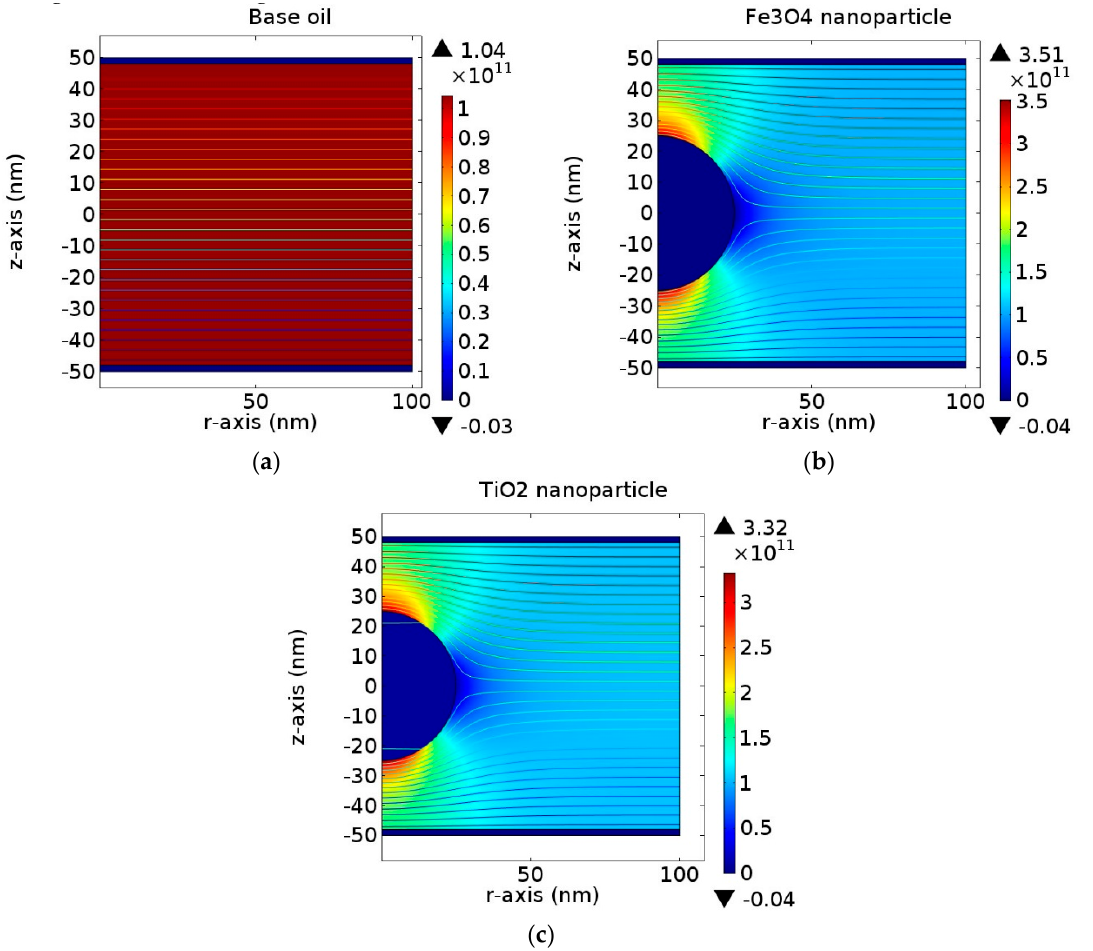
Figure 9. Electric field (V/m) distribution and electric equipotential lines for ( a ) base oil, ( b ) with Fe 3 O 4 and ( c ) TiO 2 nanoparticle.